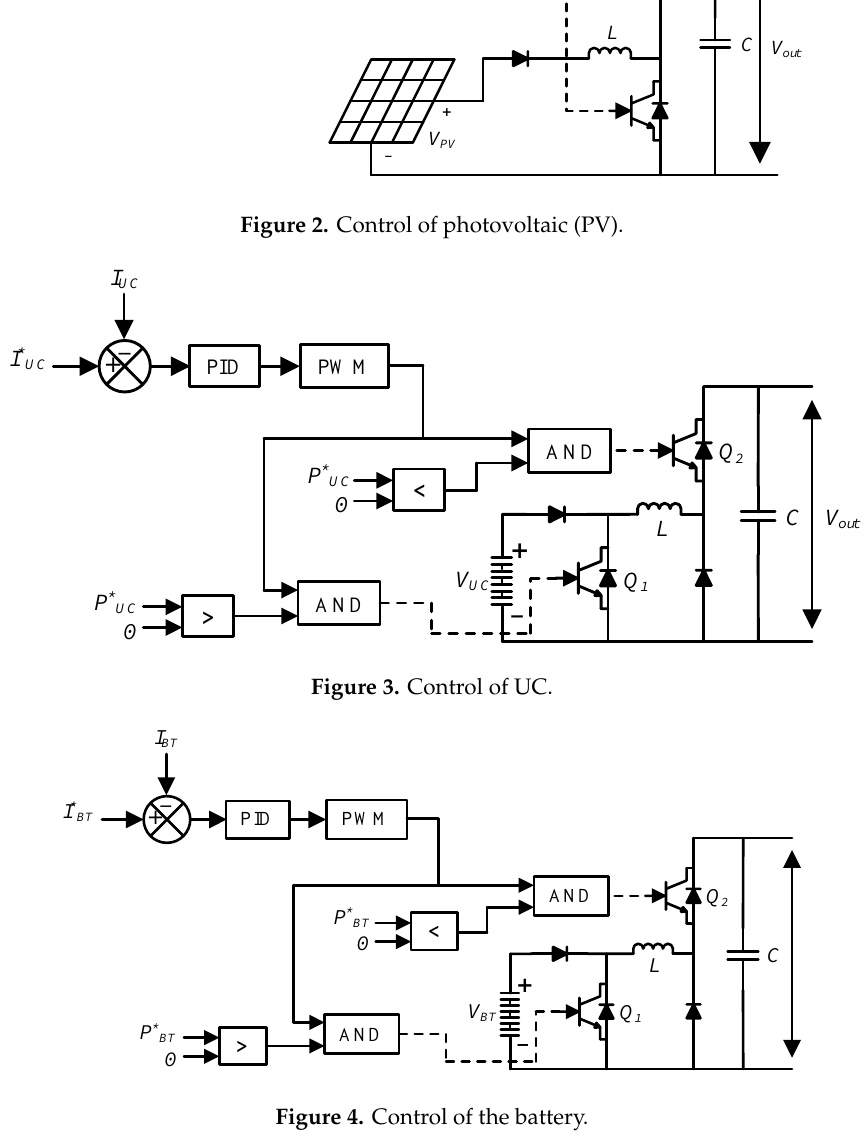
Figure 2. Control of p hotovoltaic (PV).